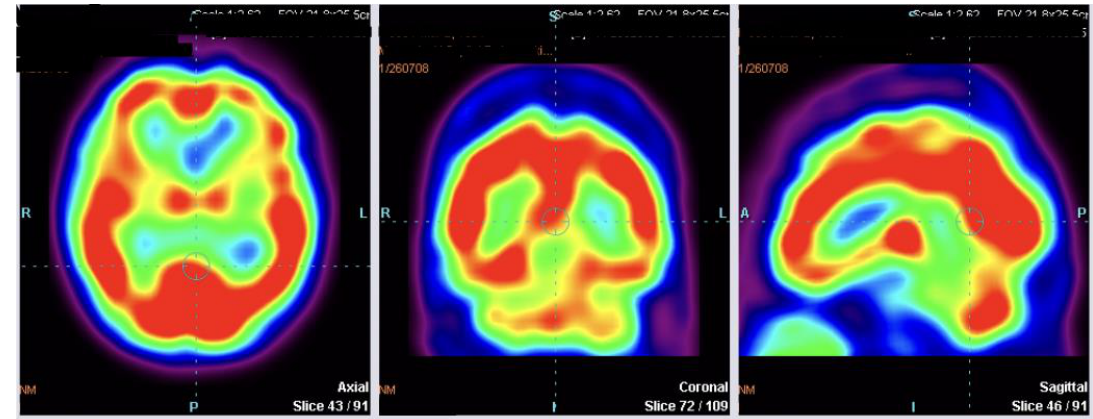
Figure 2. Frontal hypoperfusion in PSP-P — sagittal plane. Red Box: Pronounced decrease of perfu- sion within the middle frontal gyrus.